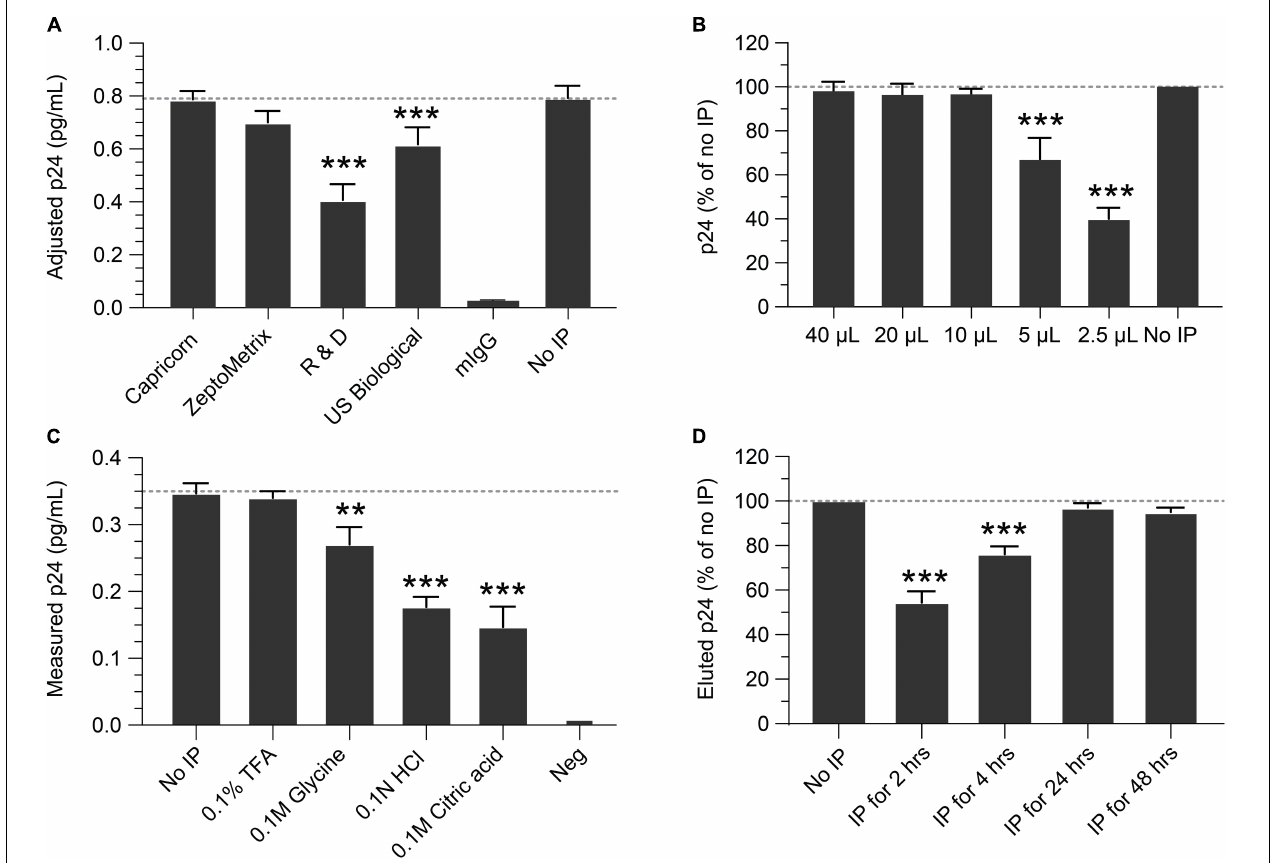
FIGURE 1 | Optimization of the immunoprecipitation (IP) Simoa assay. (A) Selection of IP capture antibody. Recovery of p24 using antibodies from various sources, conjugated to magnetic beads, showed the Capricorn antibody to yield the best capture and was similar to the input concentration after release and volume adjustment. (B) Optimization of bead concentration for p24 IP. Using a 10 mg/mL stock, adding > 10 µ L of antibody-conjugated beads to a lysate is sufficient for p24 capture. (C) Elution buffer selection. Comparing various elution buffers, 0.1% TFA had no significant difference from input solution after assay, indicating it efficiently releases p24 without destroying crucial epitopes. Other elution buffers resulted in poorer p24 recovery. (D) Time required for p24 IP capture. Recovery of p24 with 2- or 4-h incubation with antibody-conjugated beads is markedly lower than that of input solution, whereas recovery with 24 or 48 h gave recovery similar to that of the input solution (no IP). See Materials and Methods for statistical